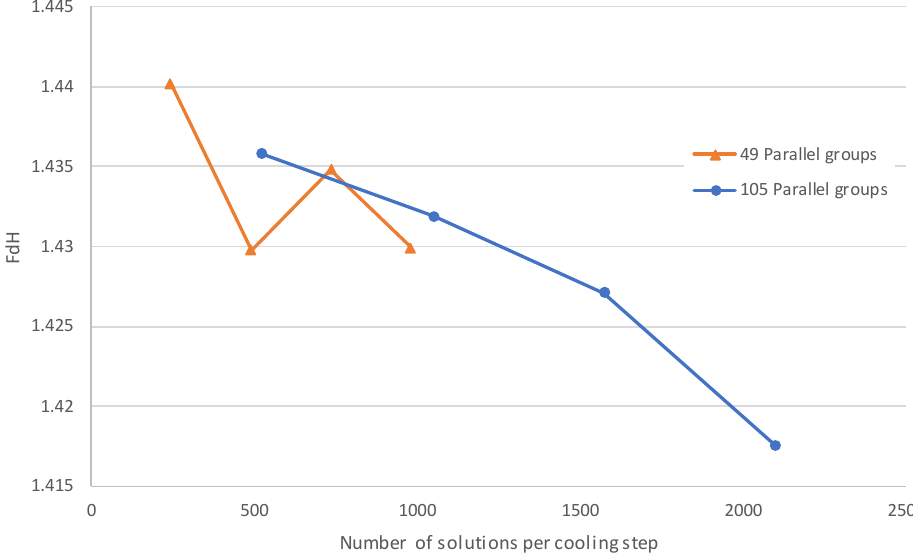
Figure 5. FdH versus total number of solutions per cooling